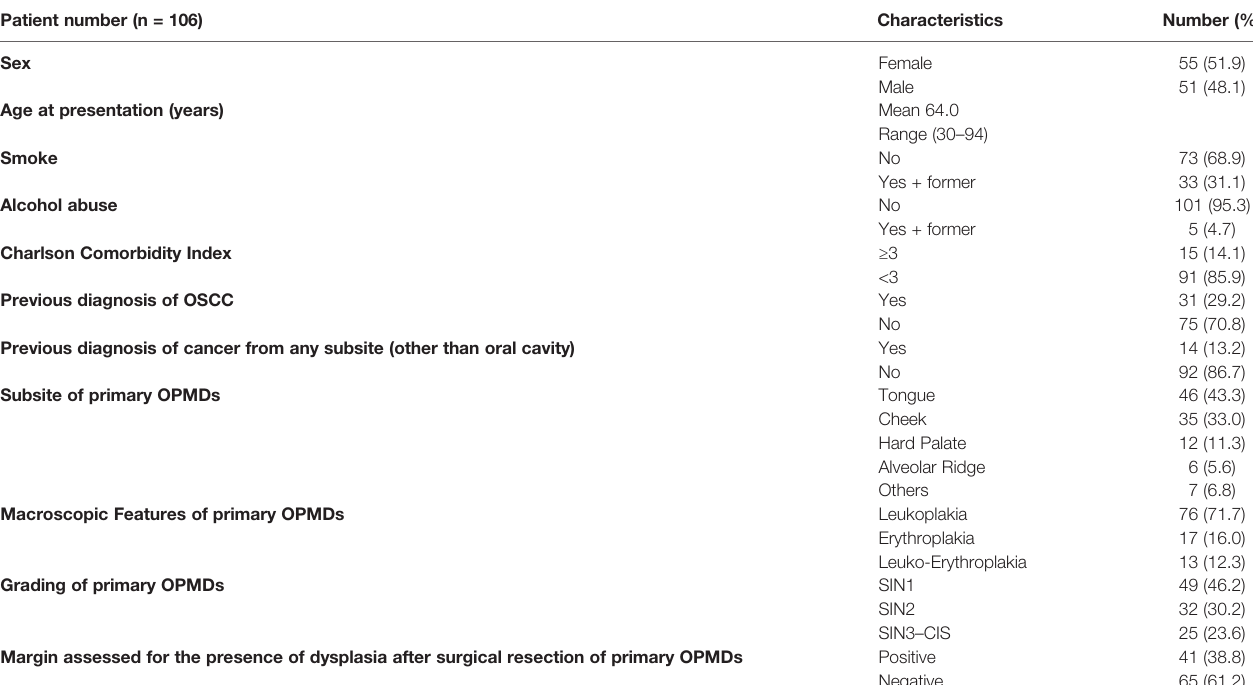
TABLE 1 | Descriptive analysis of the study